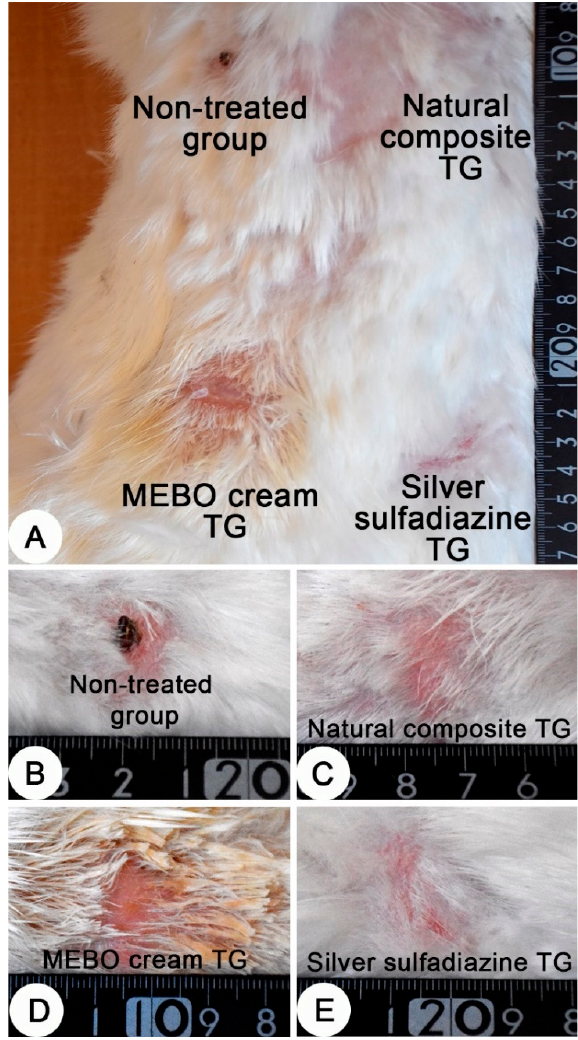
Figure 5. Skin, adult New Zealand rabbit. ( A ) Thermally induced skin burns after 28 days of treatment, showing the four burn sites in one animal. ( B – E ) a higher magnification of burn sites of figure A which representing the four treated groups. ( B ) dry crust on the burn site of the non ‐ treated group. ( C – E ) complete healing of the burn sites of the treated groups. ( C ) composite cream treated group; ( D ) MEBO ® cream treated group and ( E ) silver sulfadiazine cream treated group. Histopathologically, after 28 days of the treatment, non ‐ treated group exhibited